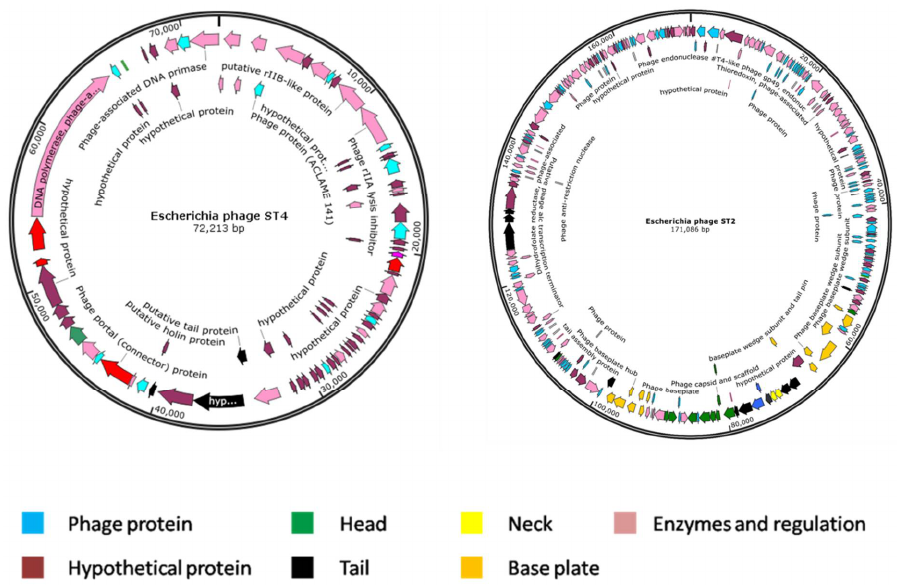
Figure 9. Map of the genome organization of Escherichia phage ST2 and ST4. Different structural proteins are indicated with different colors.